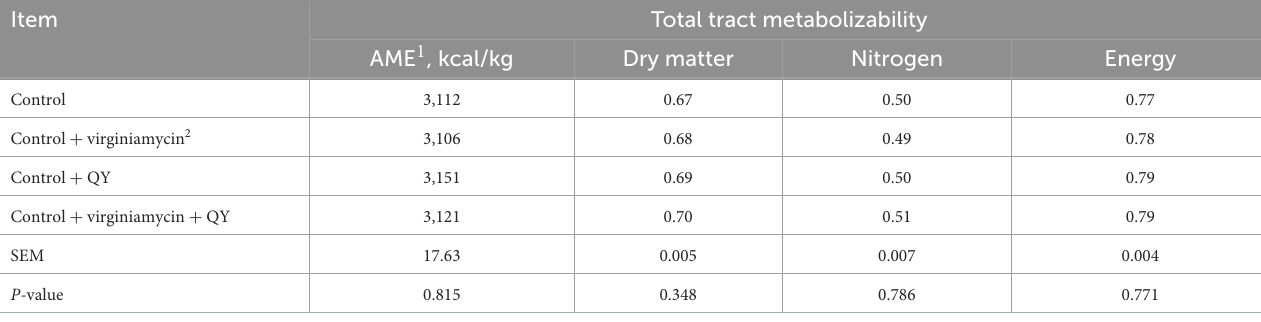
TABLE 5 Apparent metabolizable energy and coefficients of total tract metabolizability of laying breeder hens fed diets supplemented with an additive from Quillaja saponaria and Yucca schidigera (QY) at 49 weeks of age.